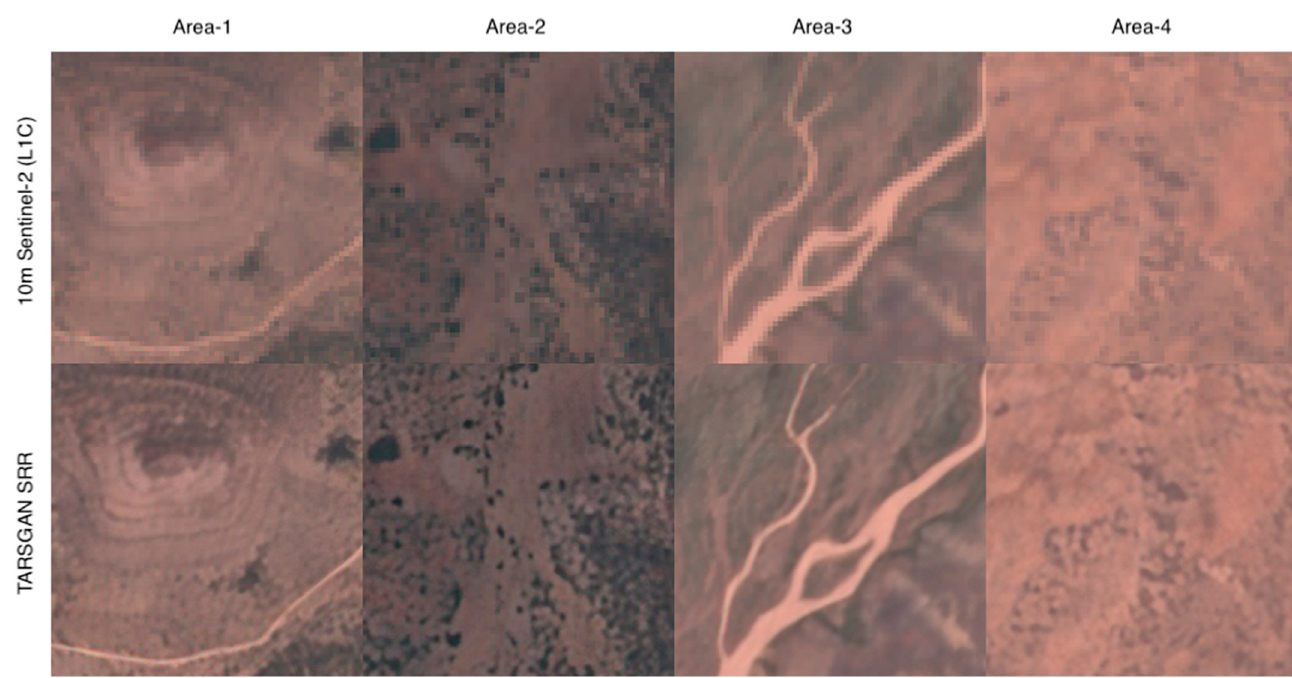
Figure 13. Cropped examples (625 m × 625 m) of the 10 m/pixel Sentinel-2 “true” colour images (L1C) and TARSGAN SRR result over Desert Rock, near Flagstaff, AZ, U.S. (Site-5). Please refer to supplementary material for full-size SRR (produced from Sentinel-2 S2A_MSIL1C_20210507T180921_N0300_R084 T12SUD_20210507T215833).